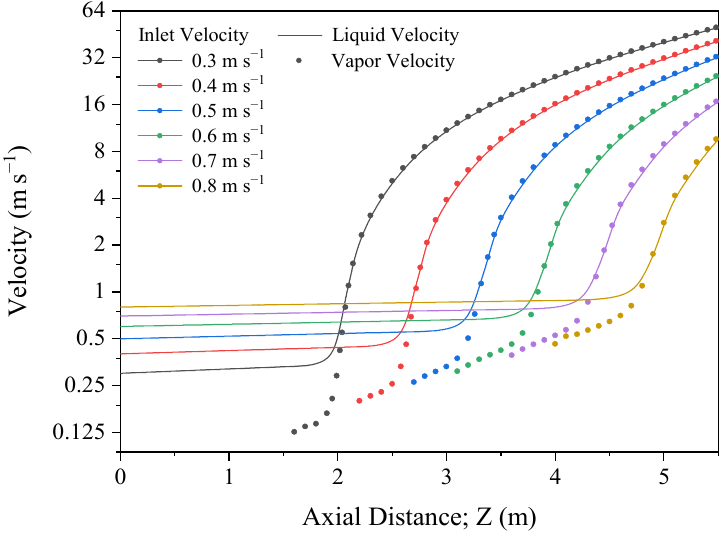
Figure 25. Average velocity of vapor phase and liquid phase along the axial direction at inlet velocities of 0.3 m · s − 1 to 0.8 m · s − 1 .